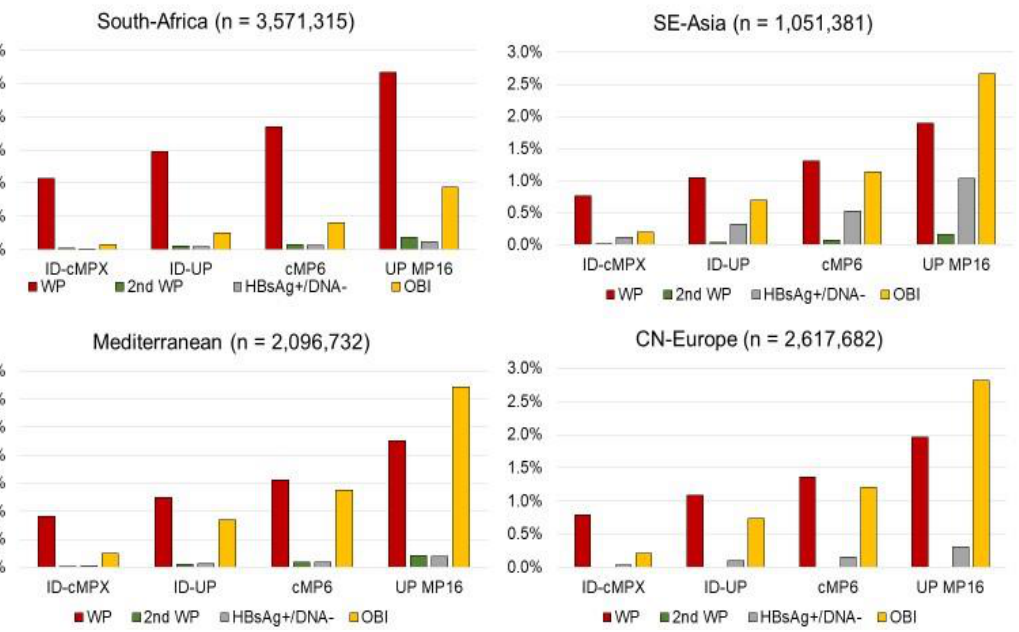
Figure 4. Residual TT-HBV risk for RBC transfusions expressed as a percentage of the overall risk in the scenario where no HBV screening had been performed. Each bar diagram represents residual risk percentages in one geographical region for 4 NAT screening scenarios (ID-cMPX = individual donation NAT with cobas MPX assay; ID-UP = individual donation NAT with Ultrio Plus assay; cMP6 = cobas MPX assay tests on minipools of 6 donations; UP MP16 = Ultrio Plus tests on minipools of 16 donations). Residual risk percentages were calculated from screening data on all donations in each of the four geographical regions. For each screening scenario, residual risk percentages are shown for four infection stages, i.e., from left to right: early pre-NAT WP (brown bar): late acute post-NAT WP (green bar), NAT-nonreactive HBsAg-positive (grey bar) and NAT-nonreactive OBI (orange bar).